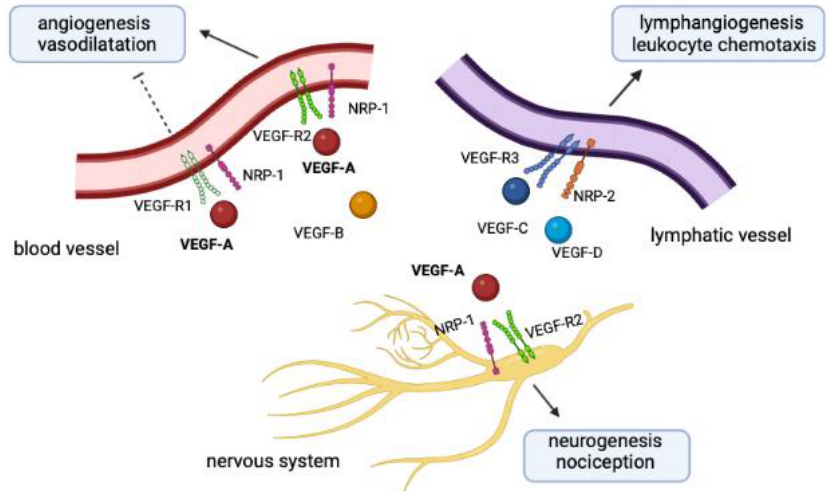
Figure 1. Physiological pathways directed by the NRP/VEGF complex in vessels and nervous system. Blood vessels, lymphatic vessels, and the nervous system express VEGF-Rs and NRPs, both of which function as receptors for VEGFs. Angiogenesis and vasodilation are the final effects of the interaction between VEGF-A/VEGF-B and the receptor complex VEGF-R1/VEGF-R2–NRP-1 in blood vessels. VEGF-C and VEGF-D instead bind to the VEGF-R3–NRP-2 receptor complex in lymphatic vessels, which may lead to lymphangiogenesis and chemotaxis of leukocytes. Finally, VEGF-A can control neurogenesis and nociception by binding to the receptor complex VEGF-R2–NRP-1 in the nervous system. Nerve fibers may in turn release VEGF-A, which has paracrine effects on receptors expressed on patterned vessels. Abbreviations: NRP: neuropilin; VEGF: vascular endothelial growth factor; VEGF-R: vascular endothelial growth factor receptor. Created with BioRender.com.